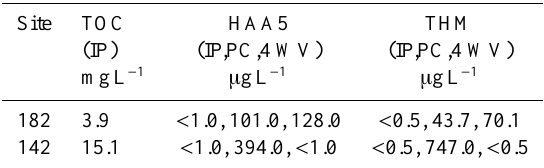
Table 7. Total Organic Carbon (TOC) concentrations following ini- tial purging of test wells (IP), and HAA5 and THM concentrations following IP, post chlorination (PC) and after 4 well volumes (WV) had been